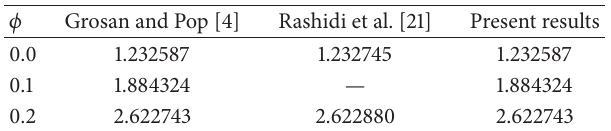
Table 2: Comparison of skin friction for different values of 𝜙 at 𝑀 = = 0 𝑓 𝑤